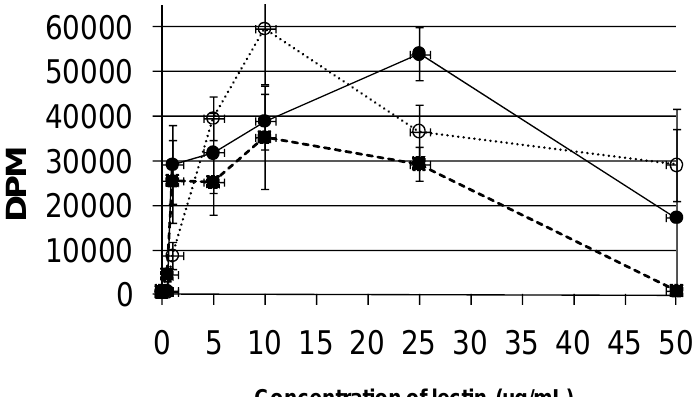
Figure 7. Comparison of the mitogenic effects of the lectin from tepary beans ( ), the leukoagglutinating lectin from Phaseolus vulgaris ( ), and Concanavalin A (